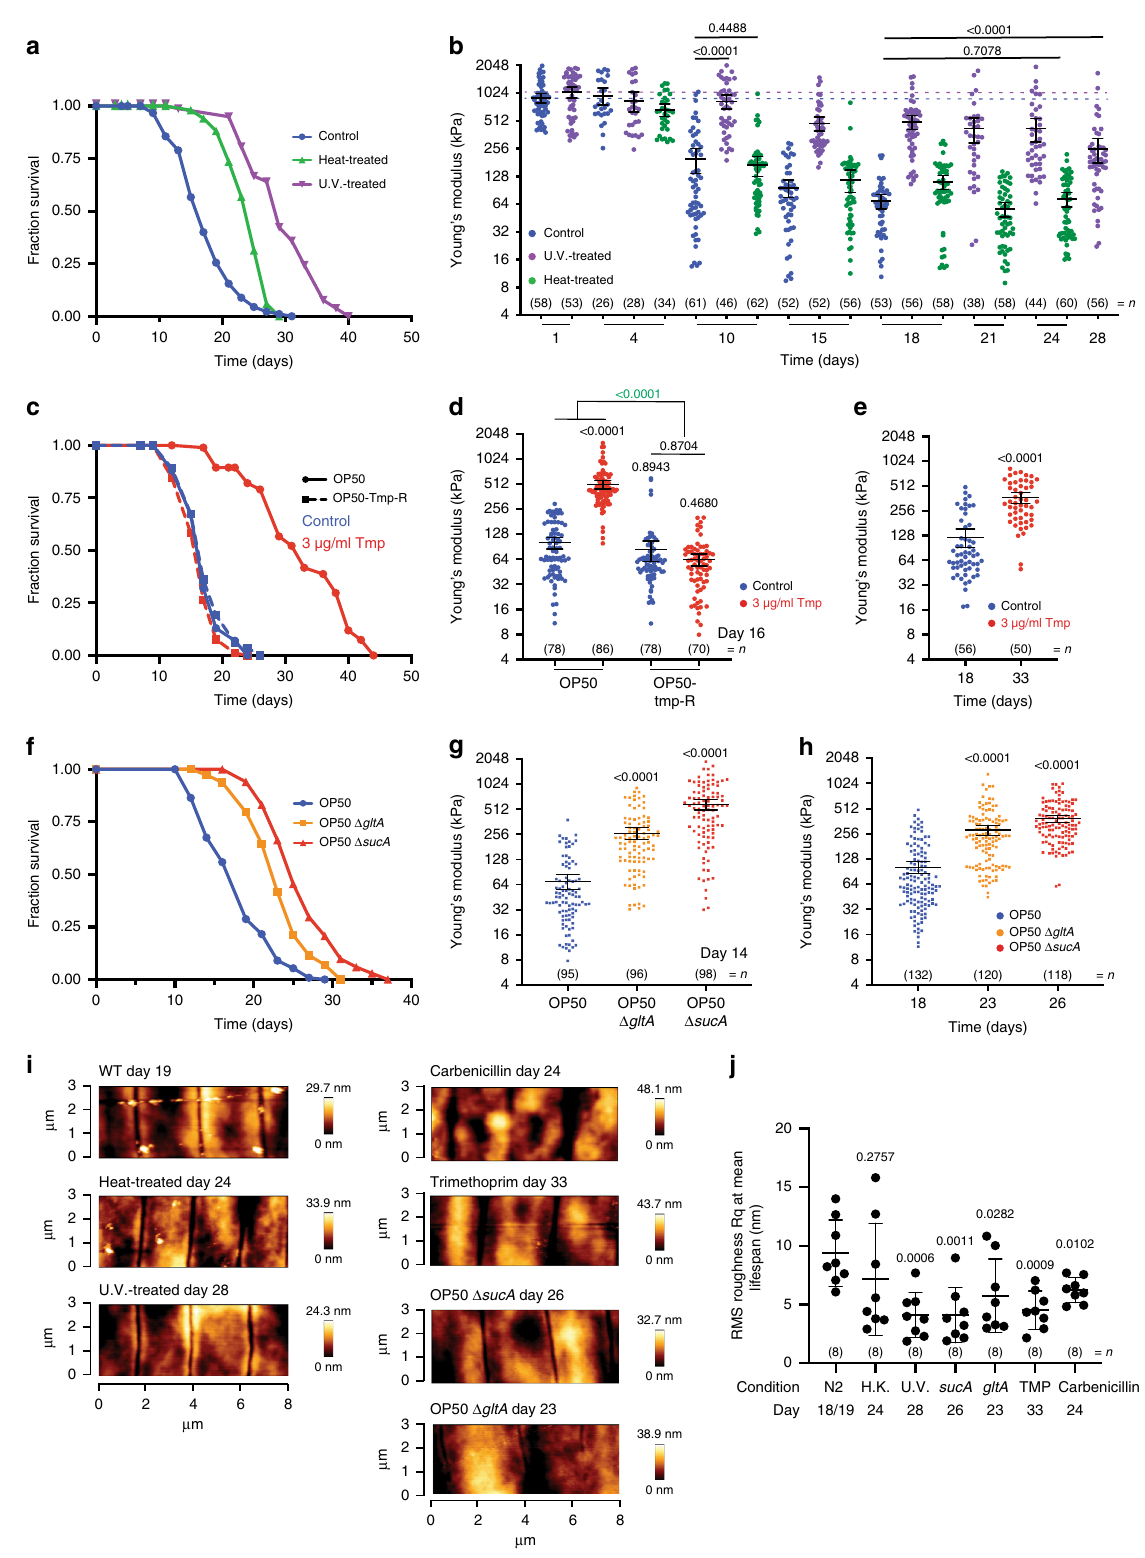
Fig. 6a, Supplementary Data 1). In particular, distinct protein protein and Bactotryptone — a pancreatic digest of casein, did not signi fi cantly alter both total growth and growth rate